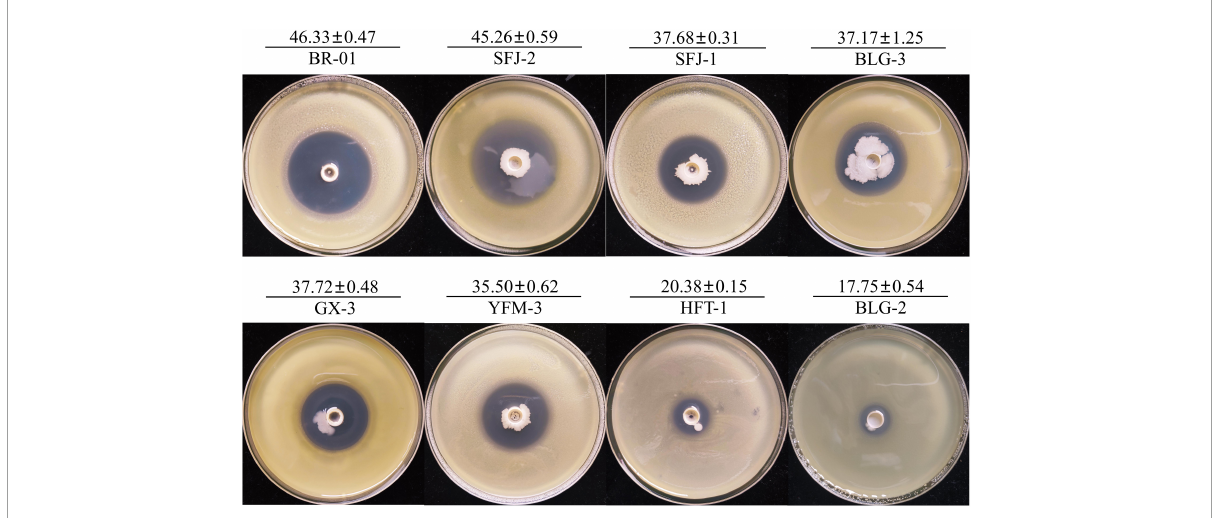
FIGURE1 Antagonistic effect of antagonistic bacteria on Xanthomonas oryzae pv. o ryzicola. Values given are the means ± standard deviations of triplicate measurements. The unit of measurement for inhibition zones is millimeter.